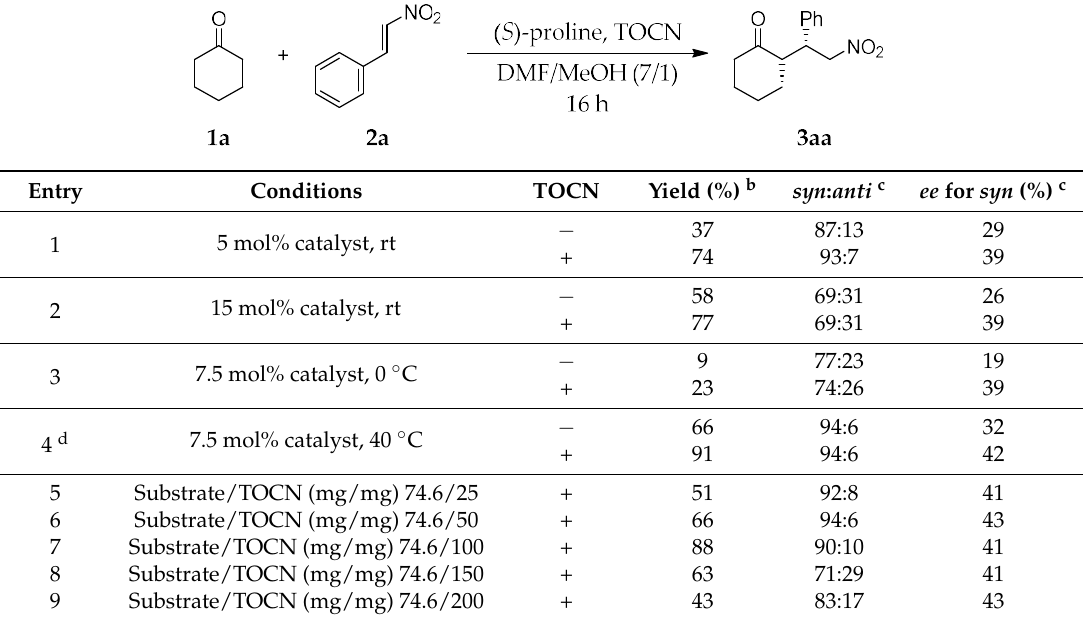
Table 2. Fine-tuning of catalyst amount, reaction temperature, and cellulose nanofiber quantity a .